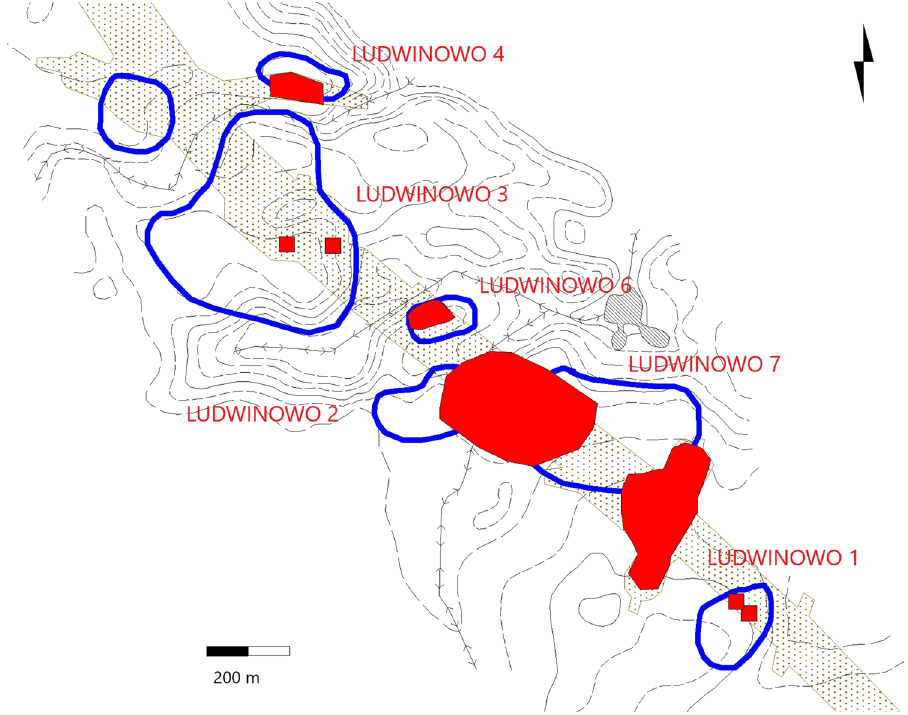
Figure 5: LBK settlement in the Ludwinowo microregion. Red area – LBK occupation, blue lines – boundaries of sites according to survey, dotted area – motorway route.